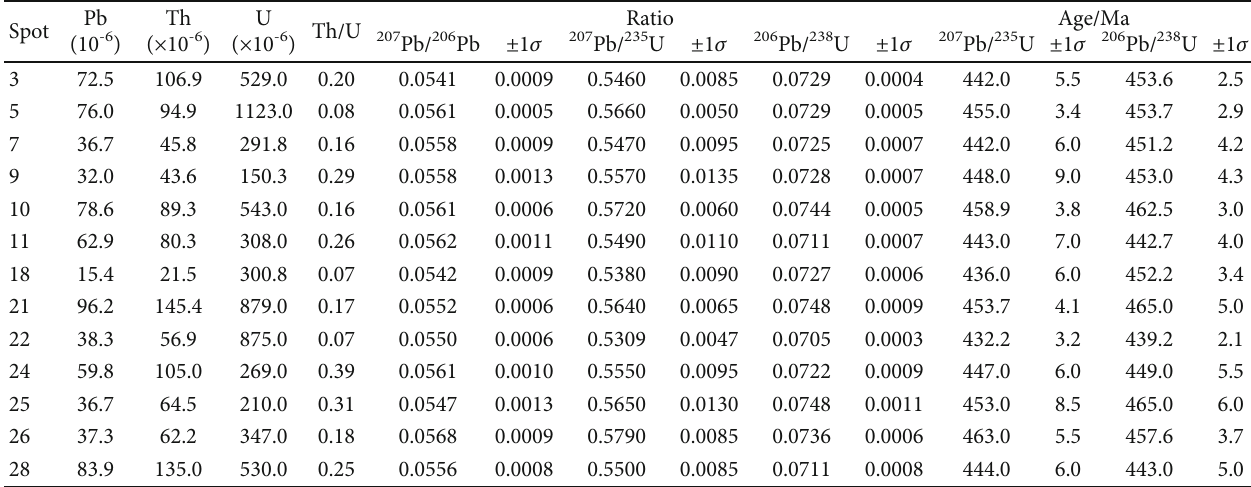
Figure 3: Zircon CL images for microbeam analyzed spots and apparent U-Pb ages (a) and zircon U-Pb concordia diagram (b, c) of the Bieyesamas monzogranite. The yellow circle represents the U-Pb analysis spot; the red circle represents the Lu-Hf analysis spot. Table 1: LA-ICP-MS U-Pb isotopic analyses for zircons from the Bieyesamas